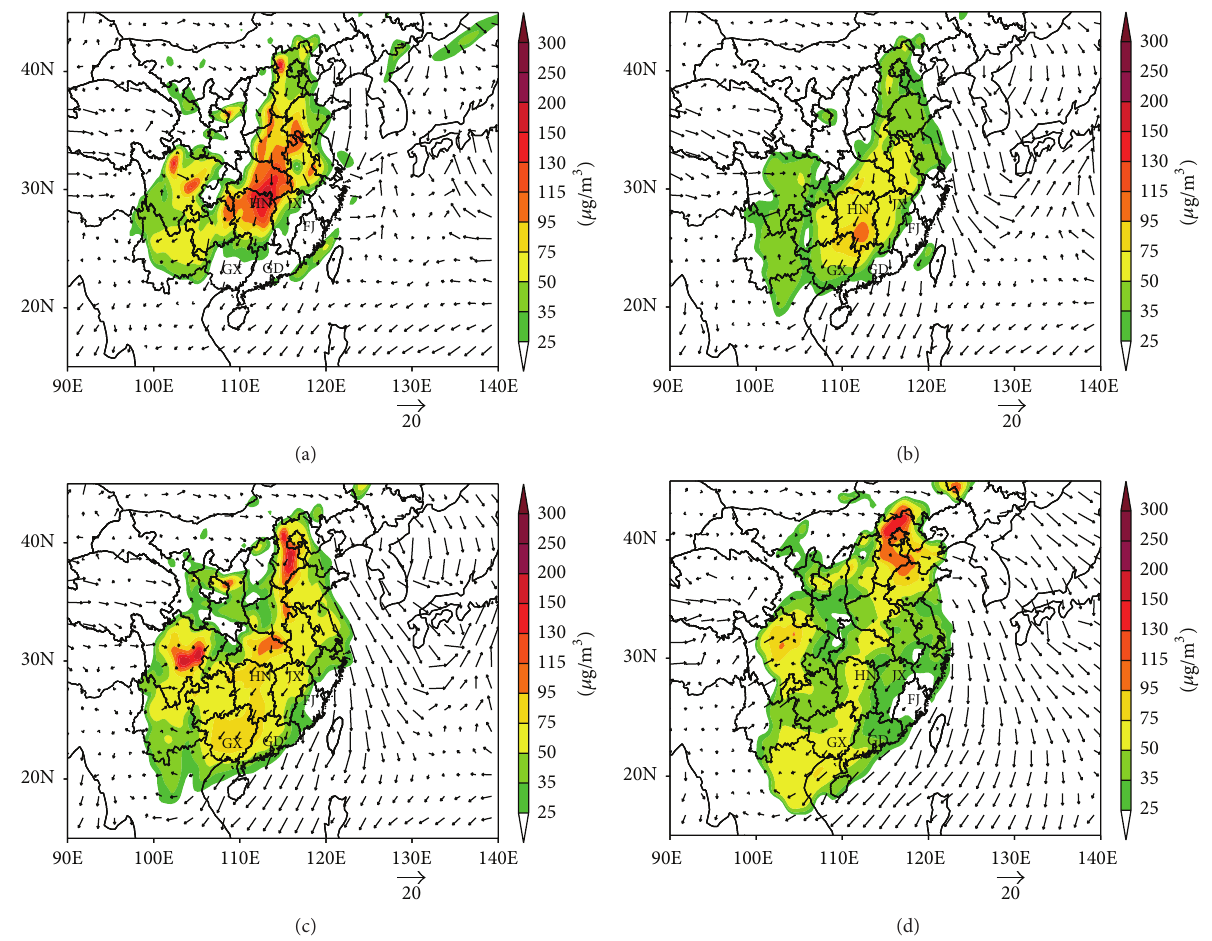
Figure 7: The spatial distribution of simulated PM 2.5 ( 𝜇 g/m 3 ) and 10m wind fields (m/s) at (a) 08:00 LST (Local Standard Time); (b) 17:00 LST; (c) 23:00 LST on 8 January; and (d) 17:00 LST on 9 January, 2014 (the names of the provinces in the pictures: Guangdong Province (GD), Guangxi Province (GX), Hunan Province (HN), Jiangxi Province (JX), and Fujian Province